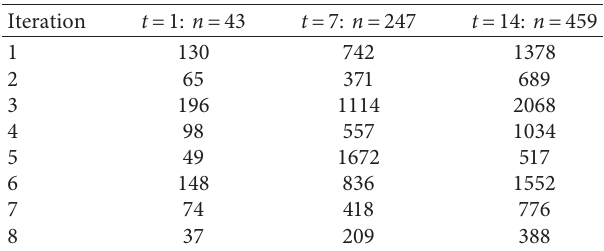
Table 1: Theorem 3 (iii) examples.